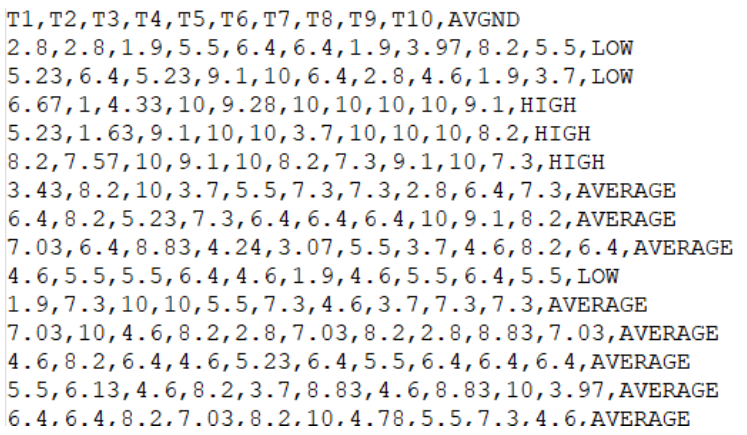
Figure 4. Dataset